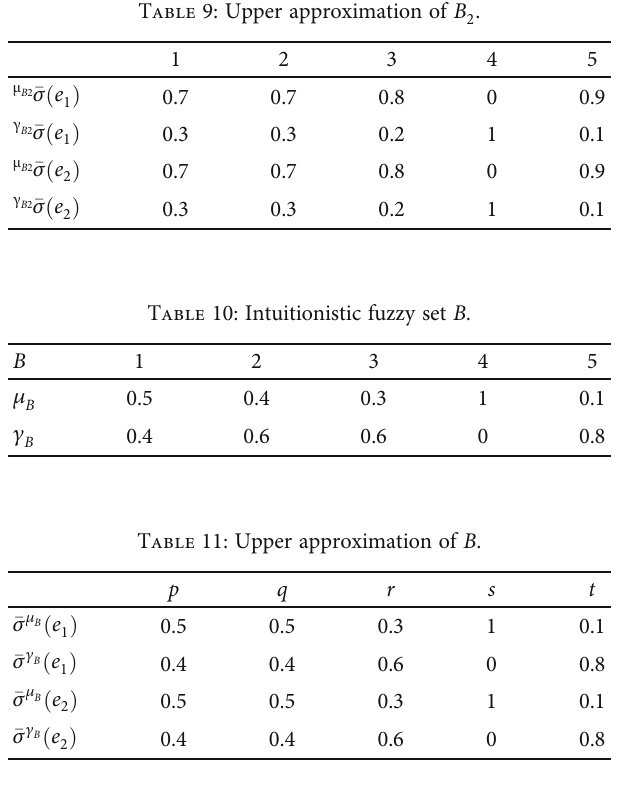
Table 9: Upper approximation of B